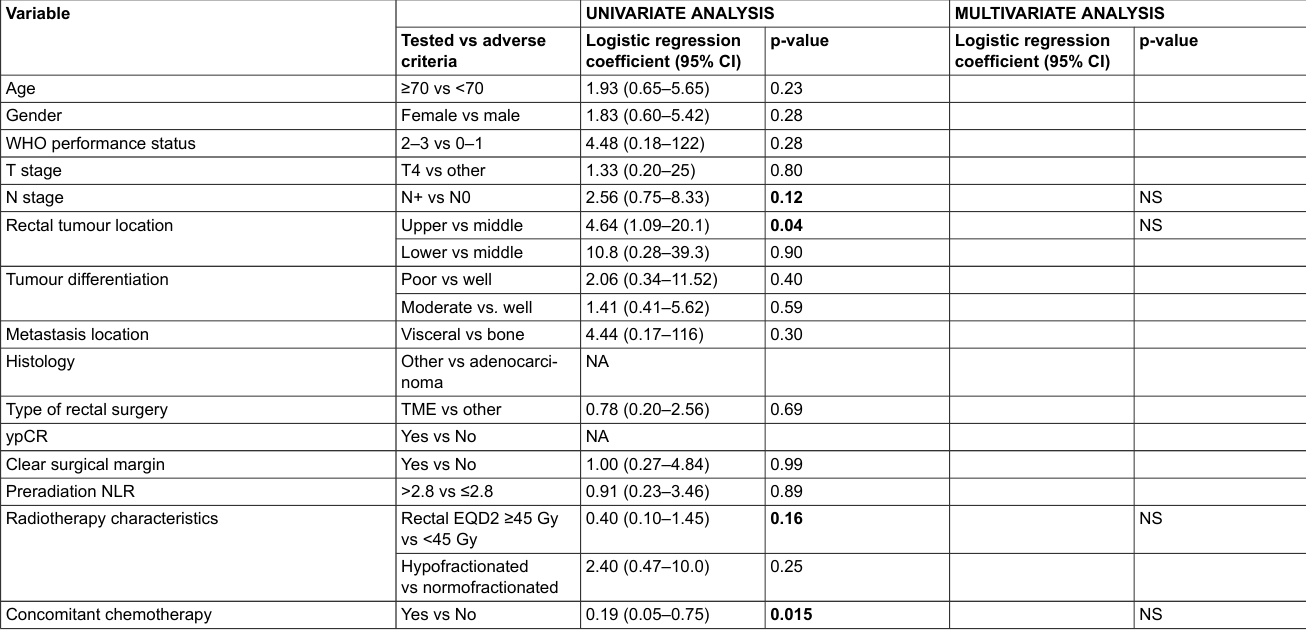
Table S2: Predictive factors for local relapse in patients undergoing primary tumour resection (n =